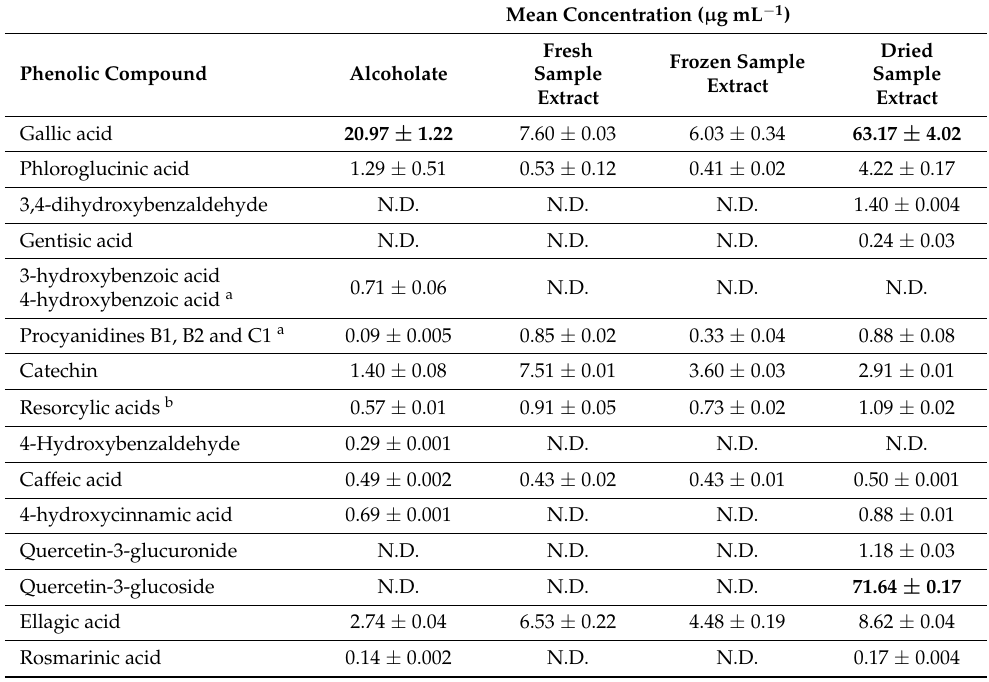
Table 2. Mean concentration ( n = 3) of phenolic compounds ( µ g mL − 1 ) found in the extracts of Filipendula vulgaris (concentrations > 10 ppm are marked in